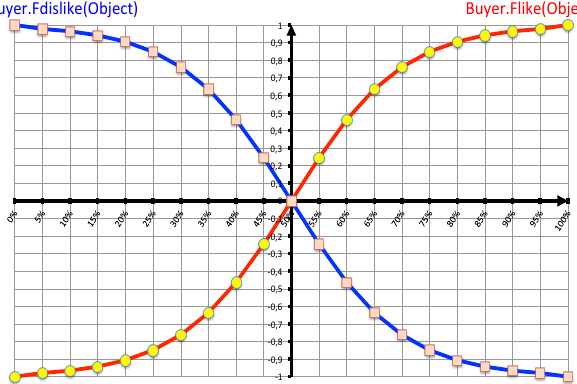
Figure 21. Like Membership functions according to OCC fLikes() fDislikes() .